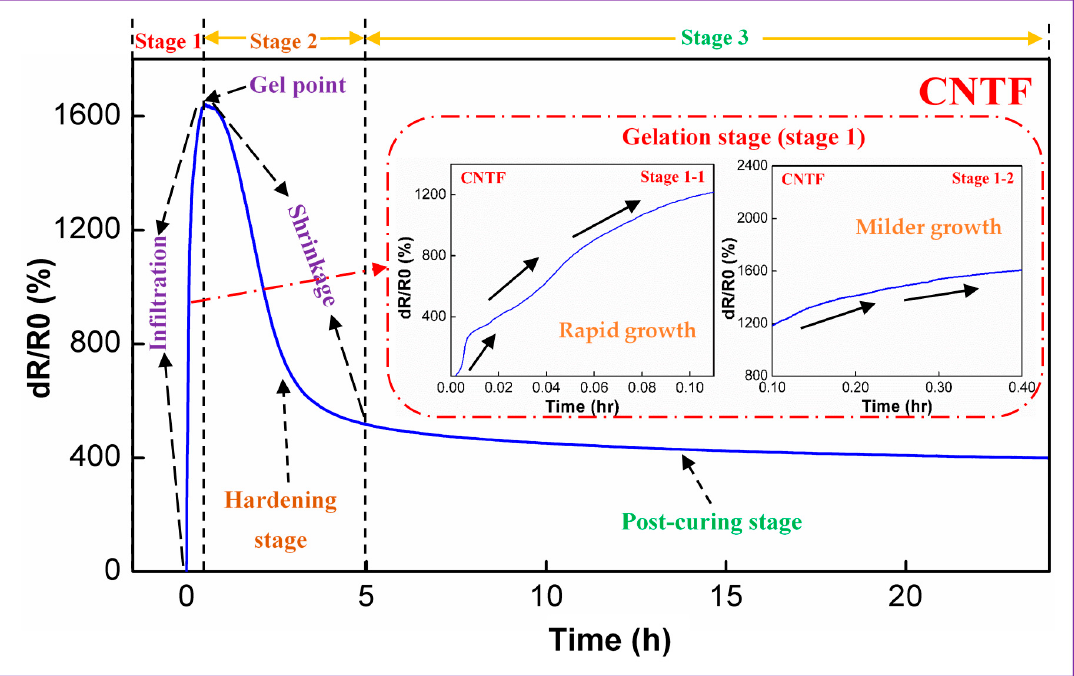
Figure 3. Representative sensing performance of a CNT-enabled fabric (CNTF) for the in-line monitoring of fiber-reinforced polymeric composites (FRP) manufacturing.